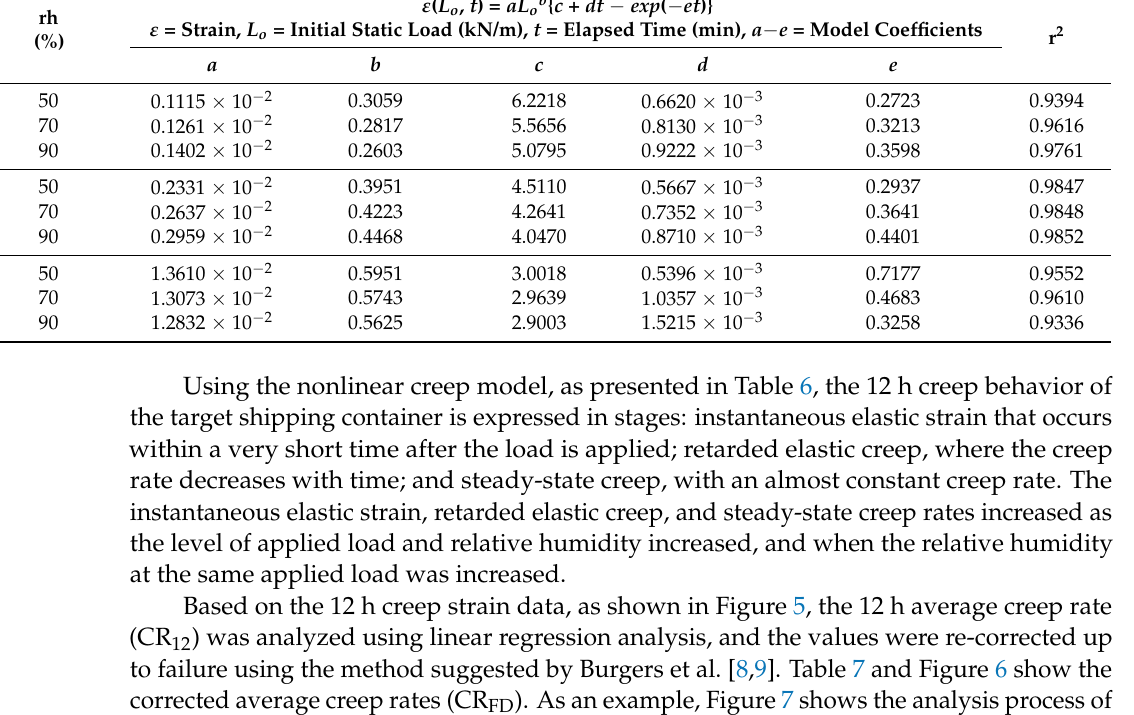
Figure 5. Response surface analysis results for 12 h creep behavior of the target shipping containers.